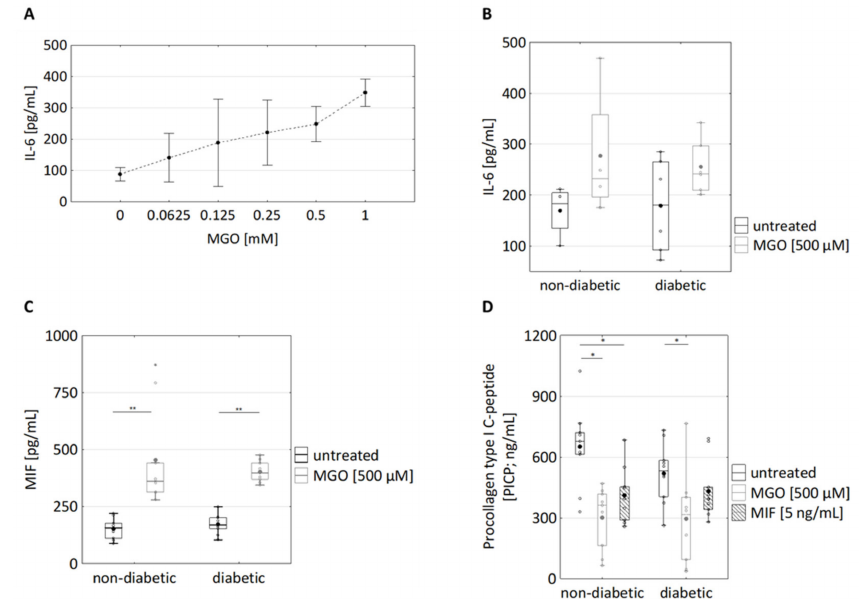
Figure 3. Effects of MGO and MIF treatment of dermal fibroblasts on the secretion of immunomodulatory cytokines and procollagen type I C-peptide. ( A ) Cultured dermal fibroblasts were treated with the indicated MGO concentrations (ranging from 0.0625 to 1 mM) for 24 h. The supernatants were analysed for IL6 levels using Homogeneous Time Resolved Fluorescence assay n = 6 (3 non-diabetic, 3 diabetic). ( B ) Cultured fibroblasts from diabetic and non-diabetic donors were treated with 500 µ M MGO for 24 h. The supernatants were analysed for IL6 levels using Homogeneous Time Resolved Fluorescence assay; n non-diabetic = 5; n diabetic = 7. ( C ) The supernatants of cultured fibroblasts from diabetic and non-diabetic donors were analysed for MIF using ELISA. They were treated with 500 µ M MGO for 24 h; n non-diabetic = 9; n diabetic = 10. ( D ) The supernatants were analysed for procollagen type I C-peptide using ELISA. Fibroblasts from diabetic and non- diabetic donors were treated with 500 µ M MGO and 10 ng/mL MIF for 24 h; n non-diabetic = 9; n diabetic = 10. Statistical significance was determined by Mann–Whitney-U-Test between groups and by Wilcoxon test for comparison between untreated and treated; * p < 0.05, ** p <